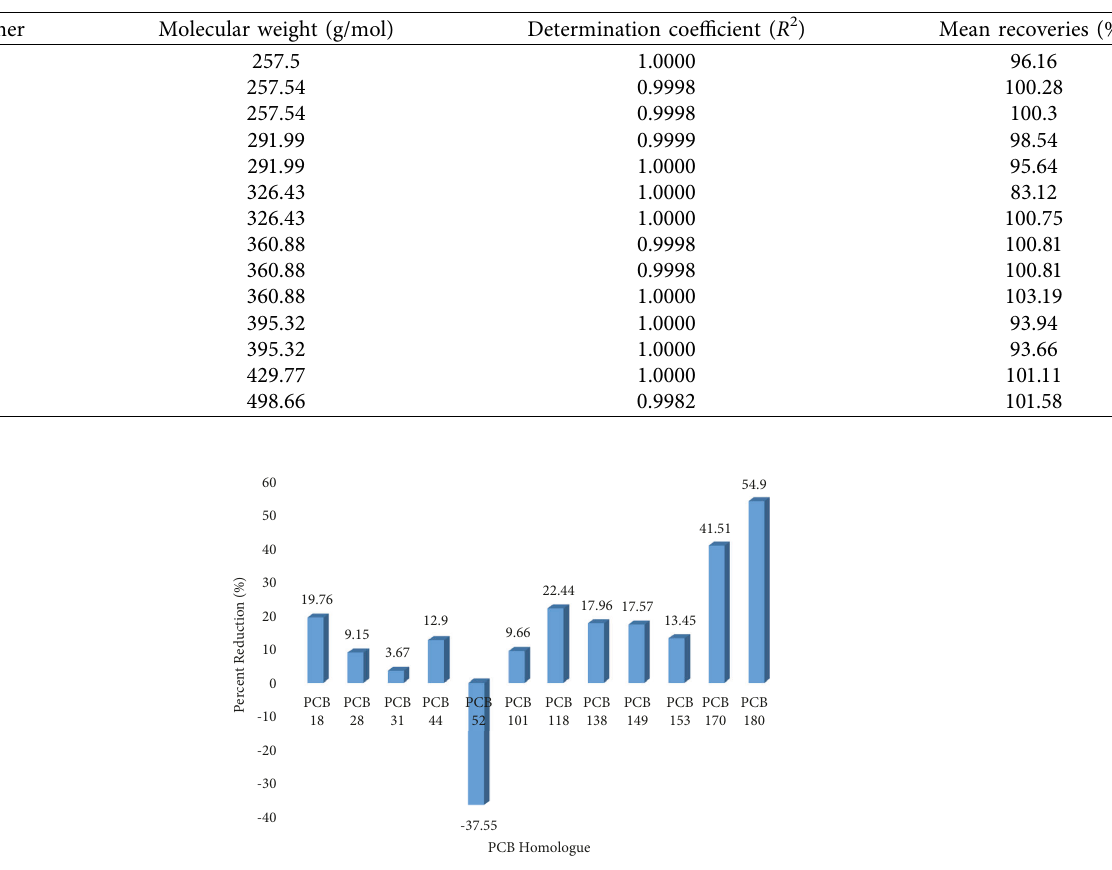
Table 4: GC-MS calibration parameters of the PCB standard at 6-point concentrations over the 5–500 μg/L range.